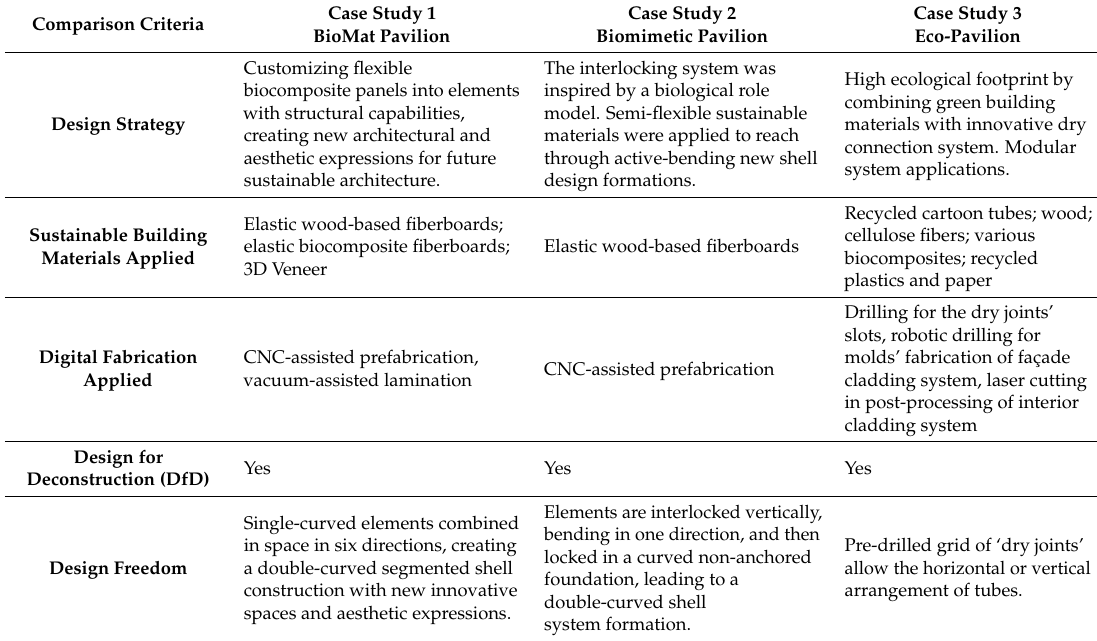
Table 1. Analytical comparison between the three case studies, regarding design, applied materials, DfD, and design freedom. CNC: computerized numerical